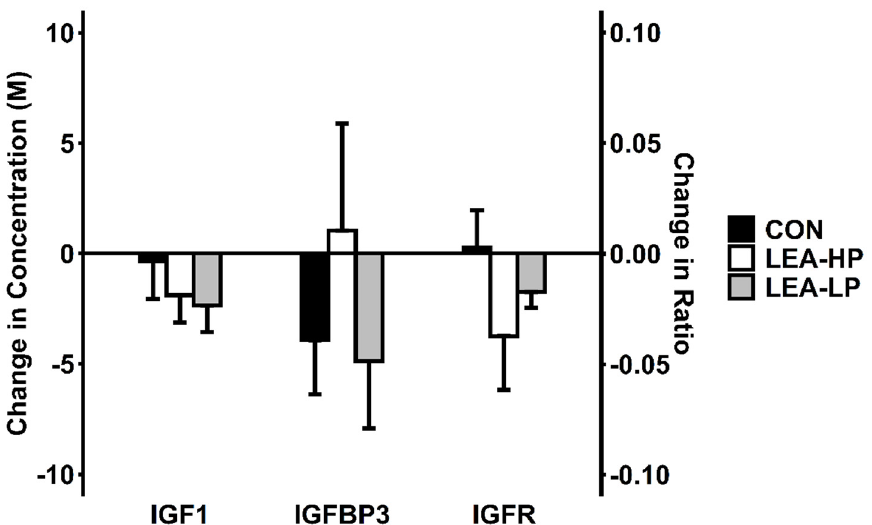
Figure 2. Changes in IGFR and its components by condition. Abbreviations: CON, control; LEA-LP, low energy availability with low protein; LEA-HP, low energy availability with high protein; M, molar concentration; IGF1, insulin-like growth factor-1; IGFBP3, insulin-like growth factor binding protein 3; IGFR, insulin-like growth factor ratio.